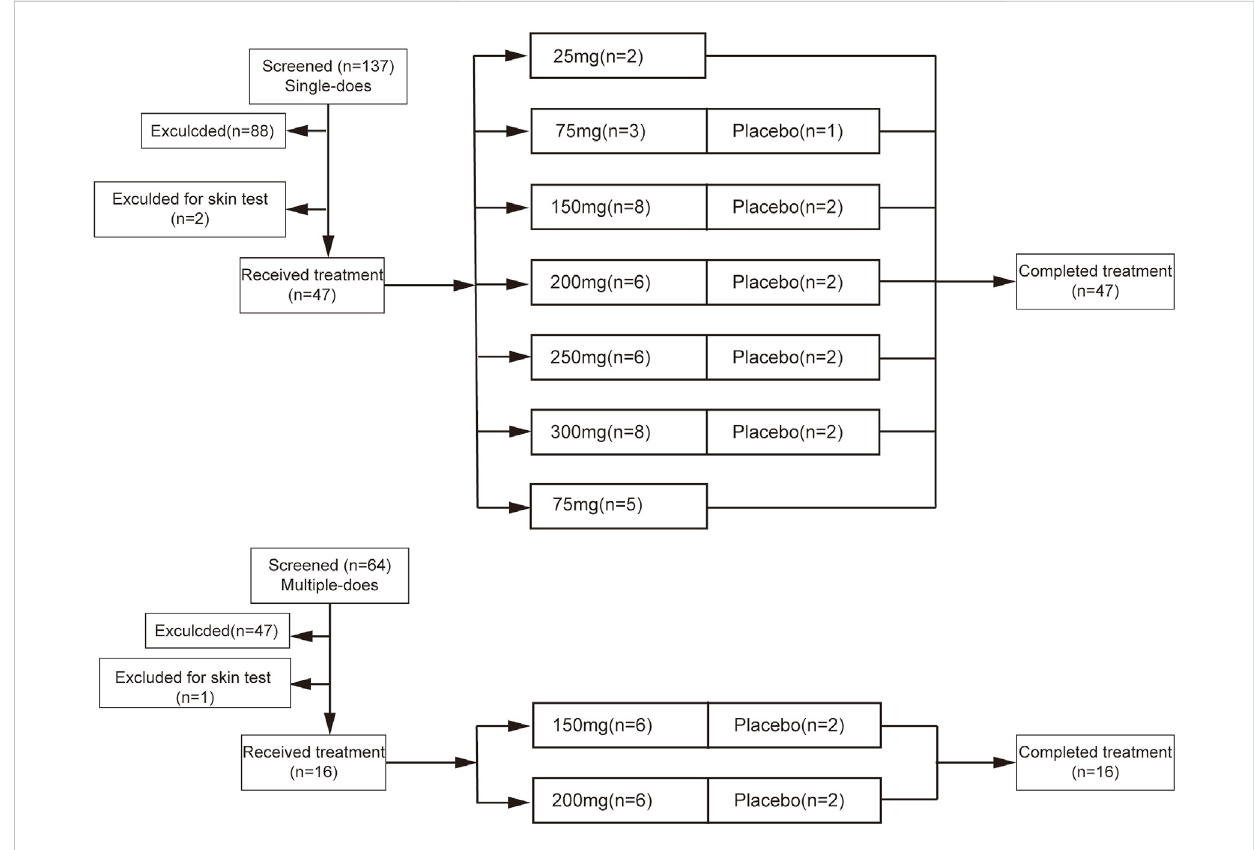
FIGURE 1 Volunteer